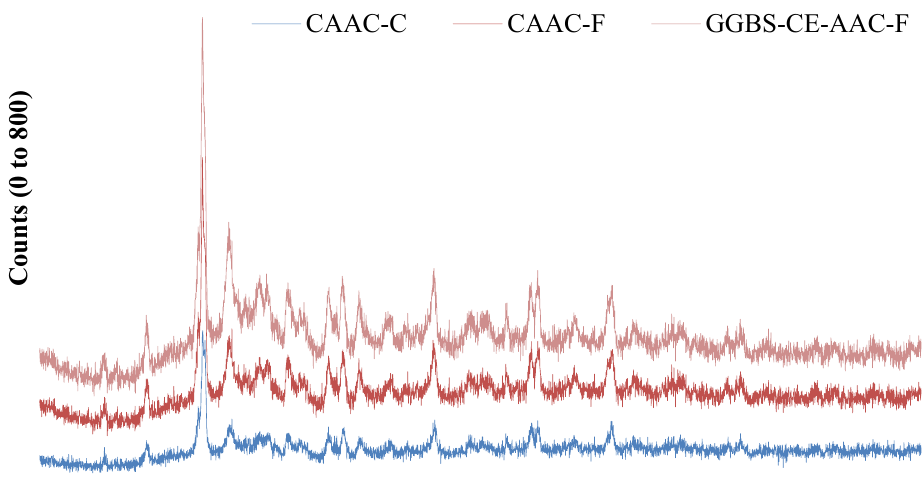
Figure 19. XRD image of AAC specimens.